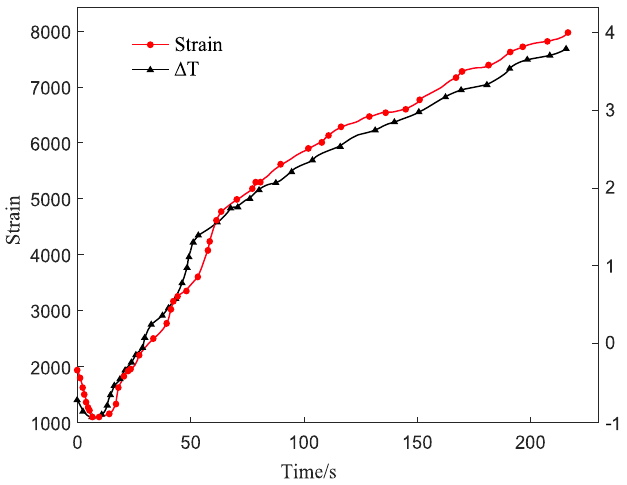
Figure 10. Specimen strain time domain diagram.